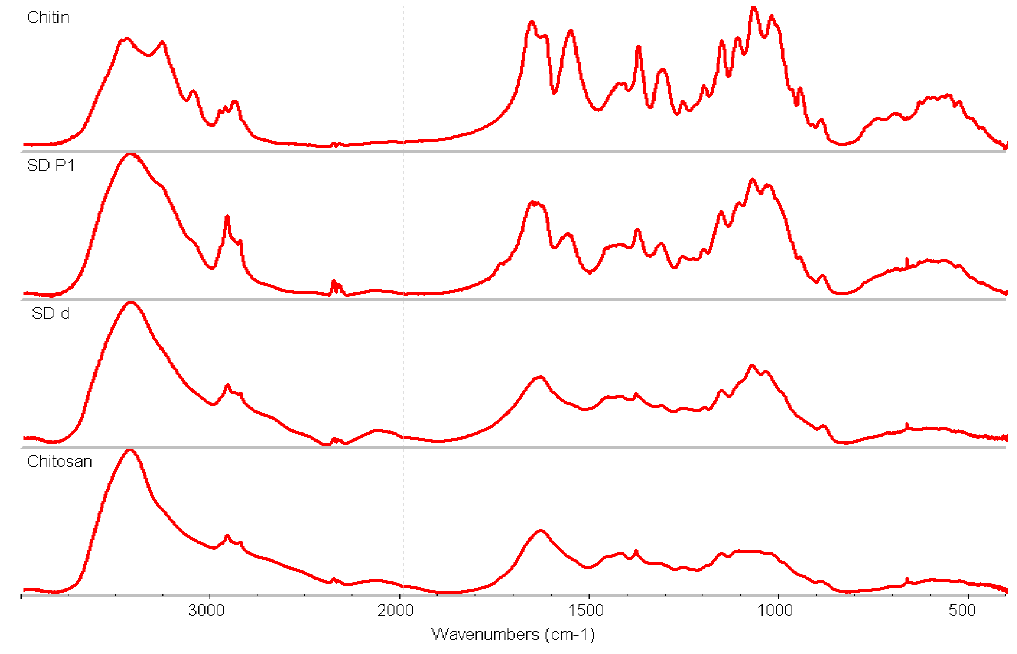
Fig. 3 Comparison of IR spectra of standards and samples of mycelia (sample A ¹ SD B ¹ SD d ).